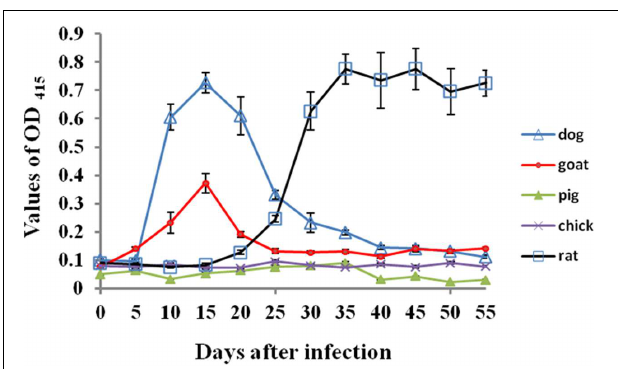
FIGURE 1 | The specific antibody responses against B. microti i n different host animals post-infection. The error bars represent three biological